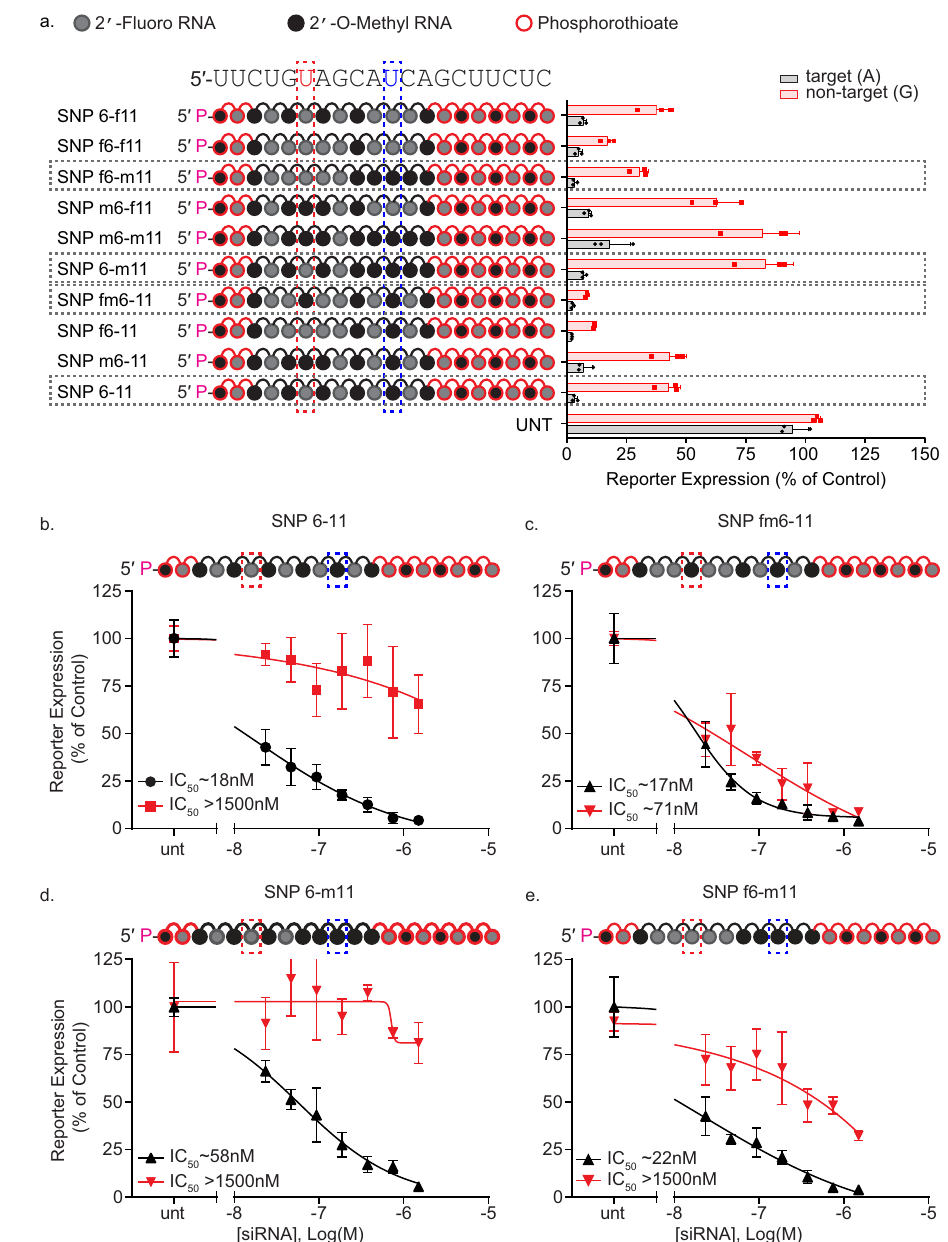
Fig. 3 | Chemical modi fi cation pattern affects allele speci fi city and ef fi cacy. a Combinations of 2 ′ -F and 2 ′ -OMe enrichment around critical positions 6 and 11 affectsiRNAactivity.Compoundsweretestedusingadual-luciferasereporterassay system in HeLa cells. The (psiCheck) reporter plasmids contain a 40mer region of huntingtin, including the target (A) SNP isoform, and non-target (G) SNP isoform. Cells were treated for 72h with 1.5 µ M siRNA. b – e 7-point dose-responses of alternativemodi fi cationpatternsshowthatbackbonemodi fi cationpatternimpacts ef fi cacy and discrimination. Compared to the original alternating modi fi cation